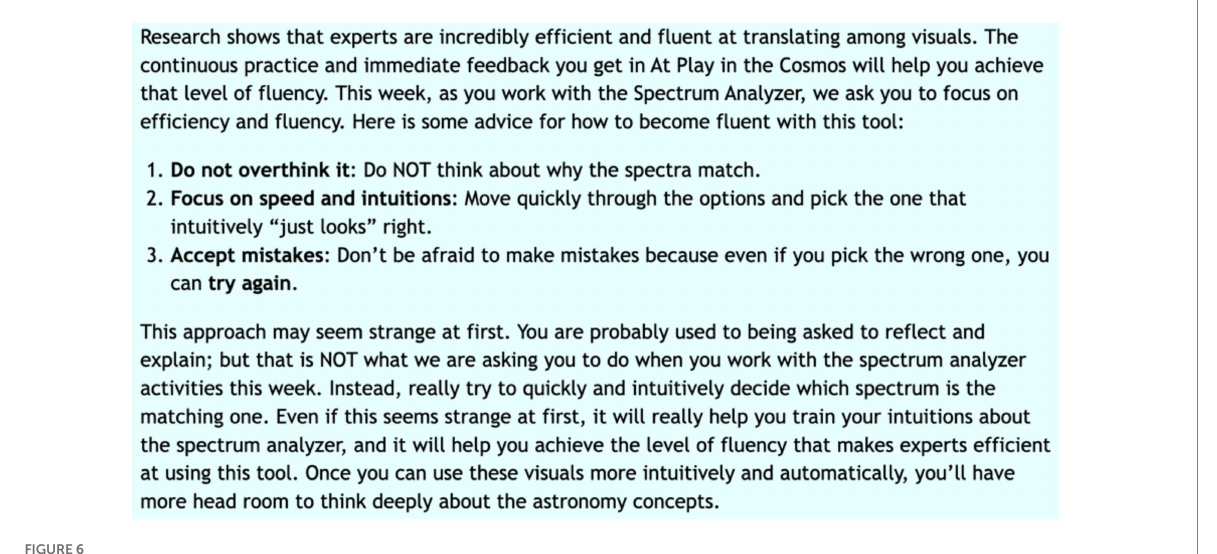
FIGURE 6 Example perceptual-fluency support: Students received a prompt that asked students to not overthink it, focus on speed and intuitions, and accept mistakes, with a concrete example (in this case, with the Spectrum